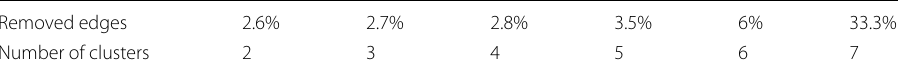
Table 9 Percentage of the removed edges and the number of detected clusters Removed edges 2.6% 2.7% 2.8% 33.3% Number of